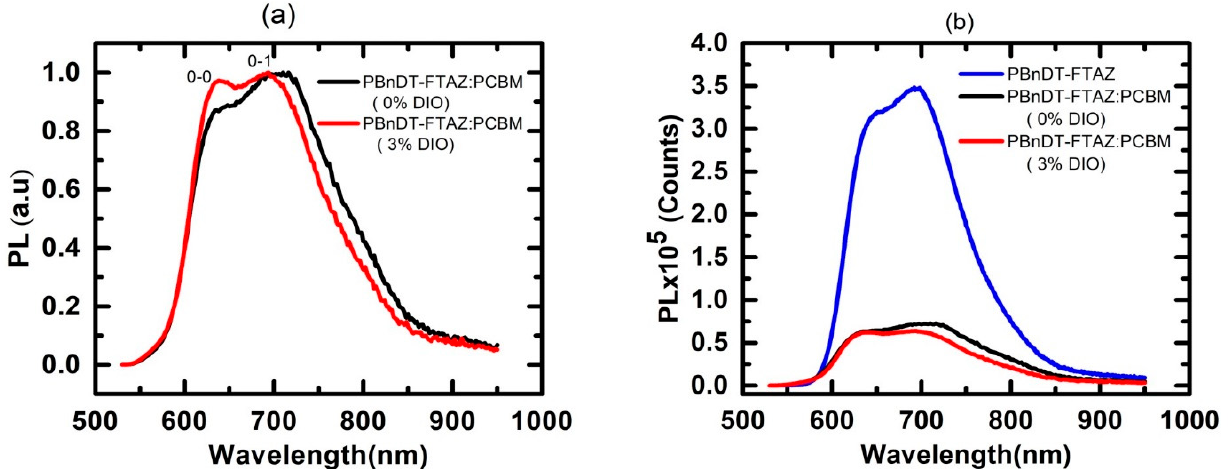
Figure 2. ( a ) Normalized Photoluminescence spectra of PBnDT-FTAZ:PCBM with and without DIO ( b ) photoluminescence spectra of PBnDT-FTAZ neat film, and blended films with and without DIO.